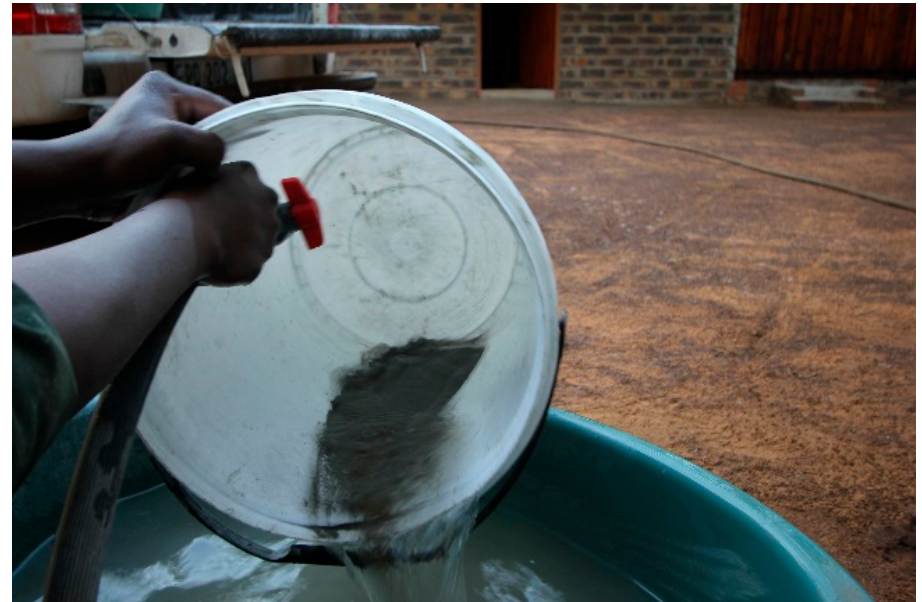
Figure 5. The final product of the ‘chair-washing’ process—in this case rich in sulphide.